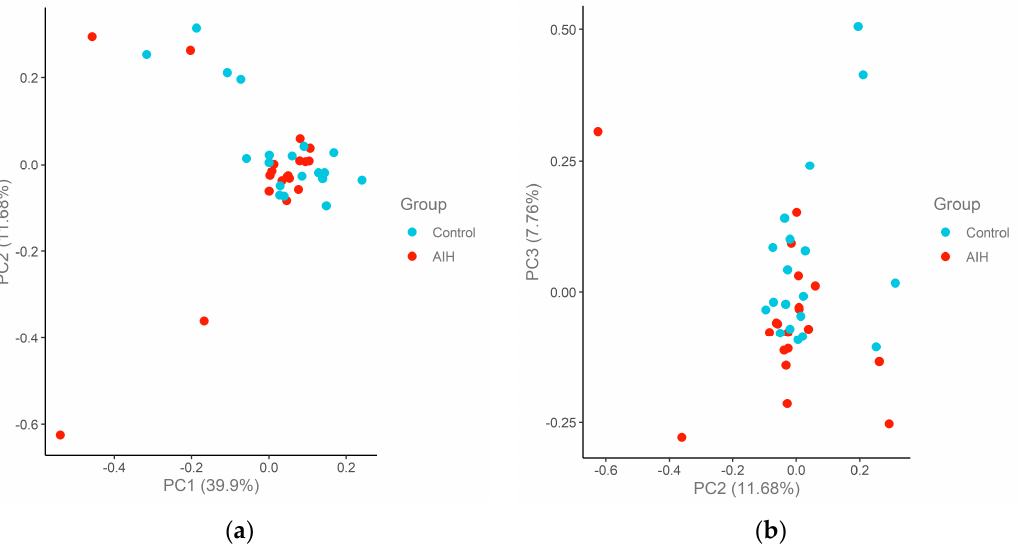
Figure 3. Principal component analysis (PCA) plots of the AIH and control cohort samples in the Inflammation panel . The samples are colored according to the group. The percentage of variation that accounted for each principal component is shown in brackets along the x and y axis label. ( a ) PC1−PC2; ( b ) PC2−PC3.